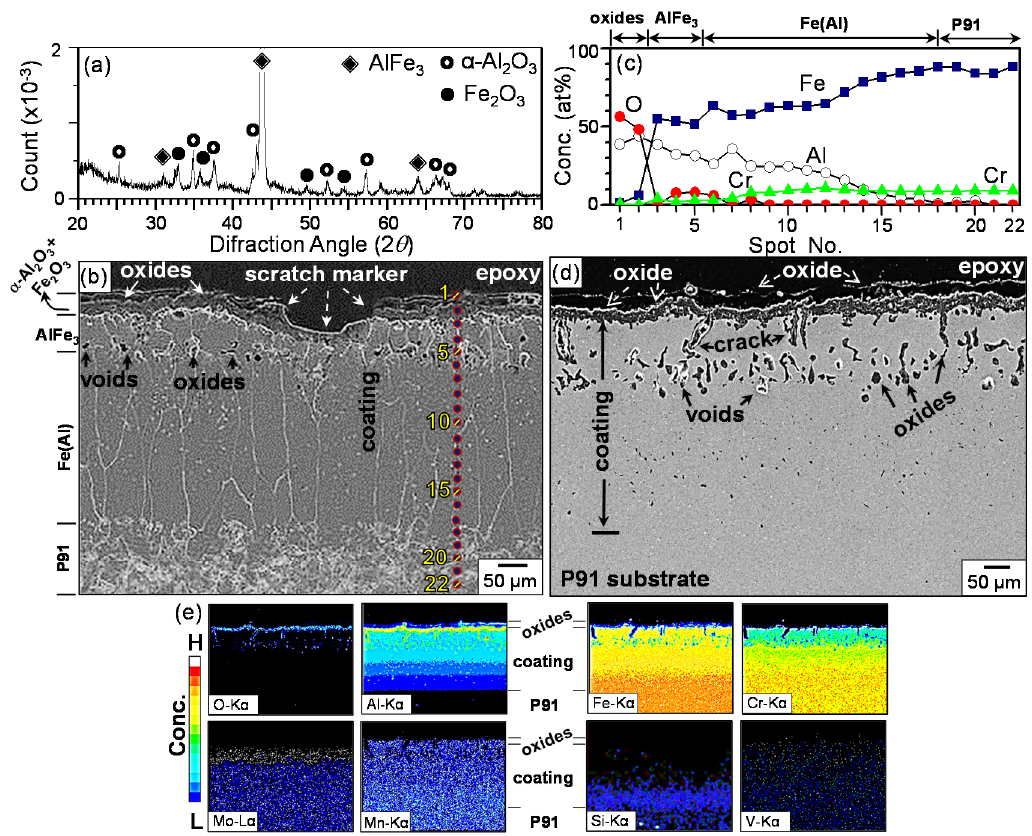
Figure 7. Al hot ‐ dipped P91 steel after oxidation at 900 °C for 20 h: ( a ) XRD pattern; ( b ) cross ‐ sectional SEM image (etched); ( c ) EDS concentration profiles along spots 1–22 marked in (b); ( d ) cross ‐ sectional EPMA image (unetched); ( e ) EPMA maps of (d).